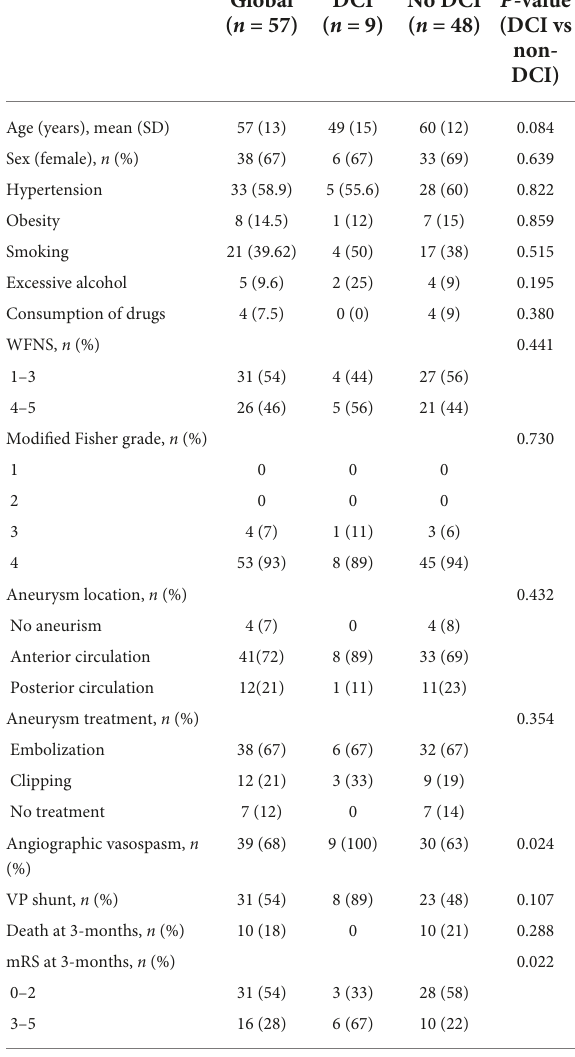
TABLE 1 Demographic and clinical variables of the aneurysmatic SAH cohort. Data are first described in the global group and then categorized according to the presence or absence of delayed cerebral ischemia